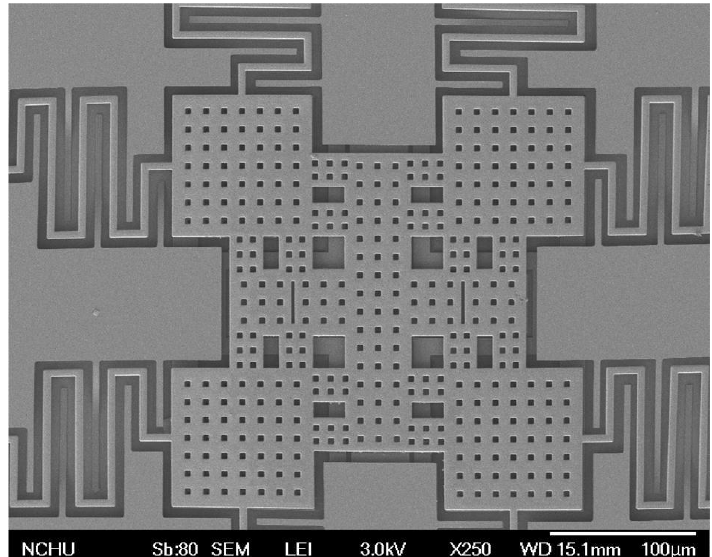
Figure 12. SEM image of the membrane with